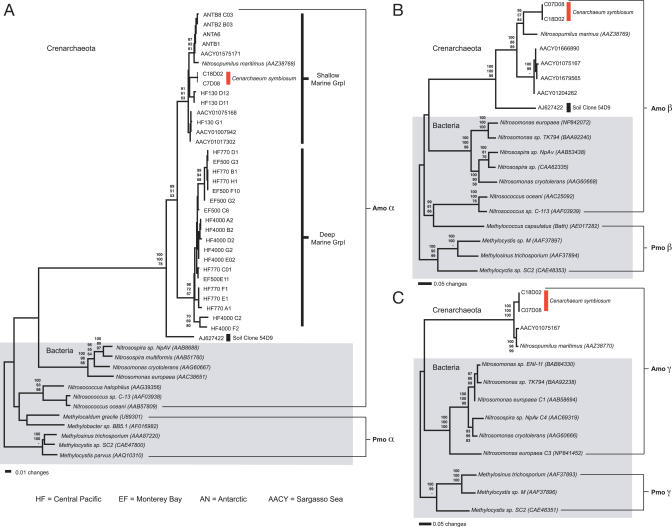
Phylogenetic Comparison of Ammonia Monooxygenase α, β, and γ Subunits Identified in
C. symbiosum and Environmental DNA Libraries
(A) α, (B) β, and (C) γ. The taxonomic distribution of α subunits includes sequences recovered from environmental library screening with degenerate primers targeting the
amoA locus (see
Materials and Methods). Distance (top), parsimony (middle), and maximum-likelihood (bottom) bootstrap values providing more than 50% support are indicated. Distance and parsimony values are based on 1,000 replicates each, and maximum-likelihood values are based on 10,000 replicates. Trees are rooted with the corresponding subunits for particulate methane monooxygenase.